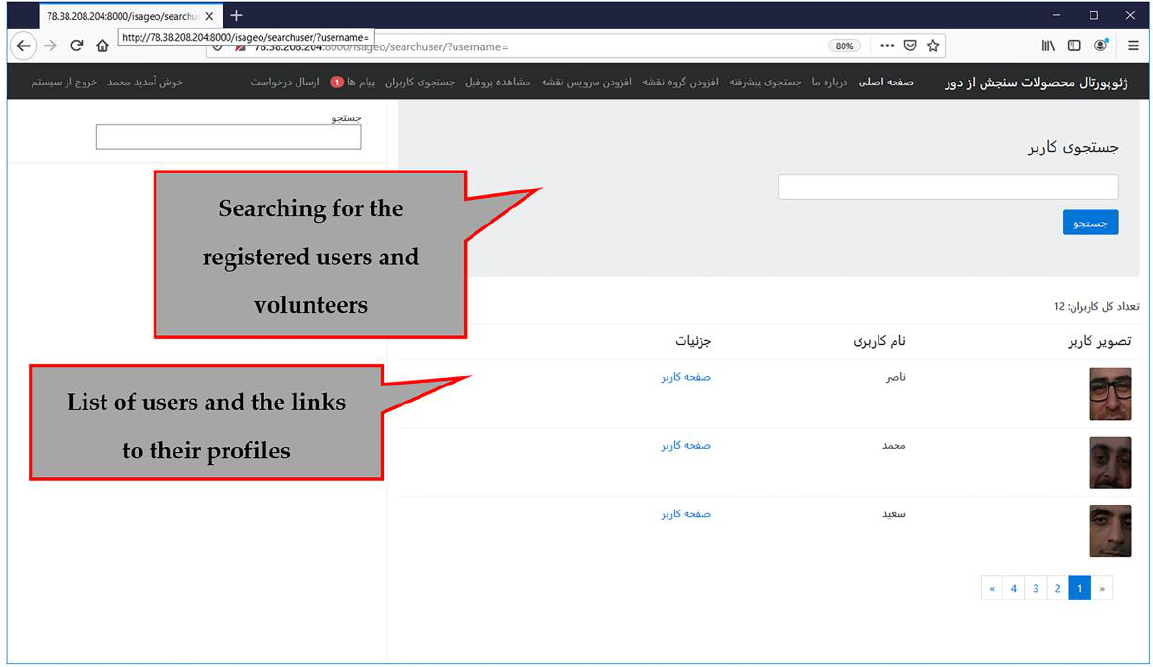
Figure 11. Searching for registered users and volunteers and visiting their profile.